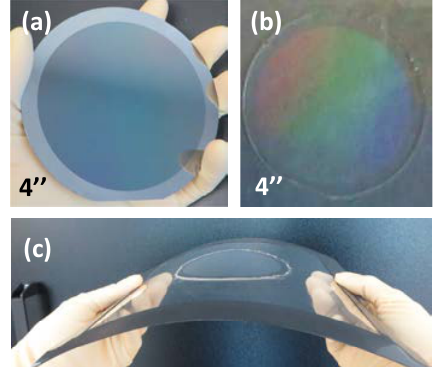
Fig. 2. Silicon master (4”) (a) and manufactured PDMS mold (b) fixed on a thin glass plate (c) used for the NIL grating manufacturing.